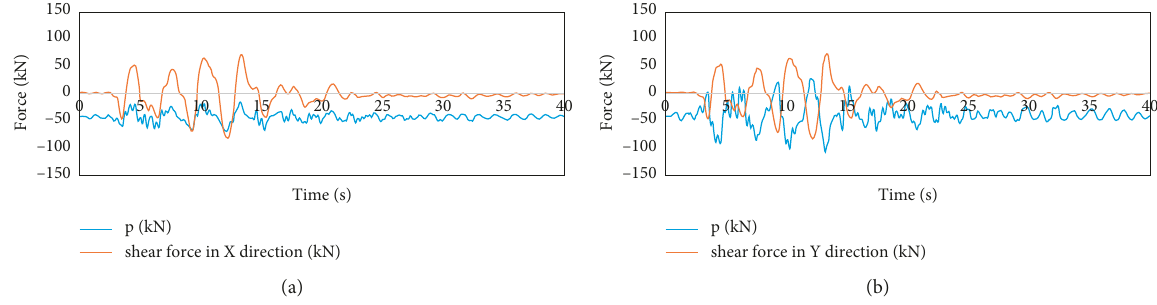
Figure 43: Time course curve of bearing force under N94 seismic wave. (a) X-directional input. (b) Y-directional input.